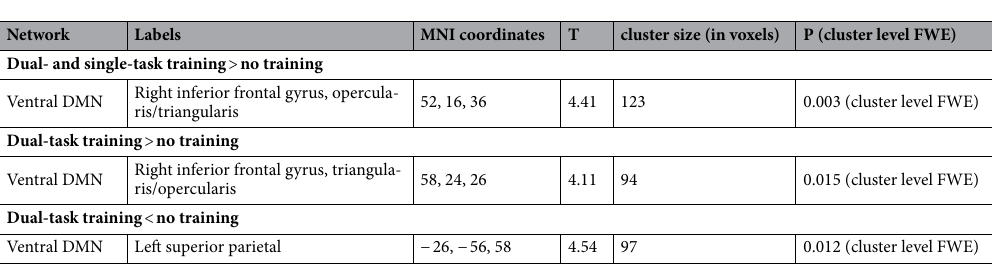
Table 1. Significant group x time interaction in functional connectivity of resting state